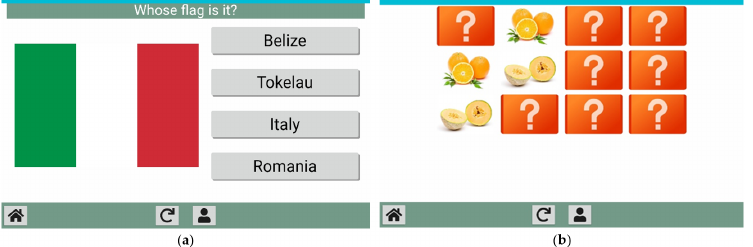
Figure 4. Examples of the “flags” orientation game ( a ) and the memory game “pairs” ( b ).